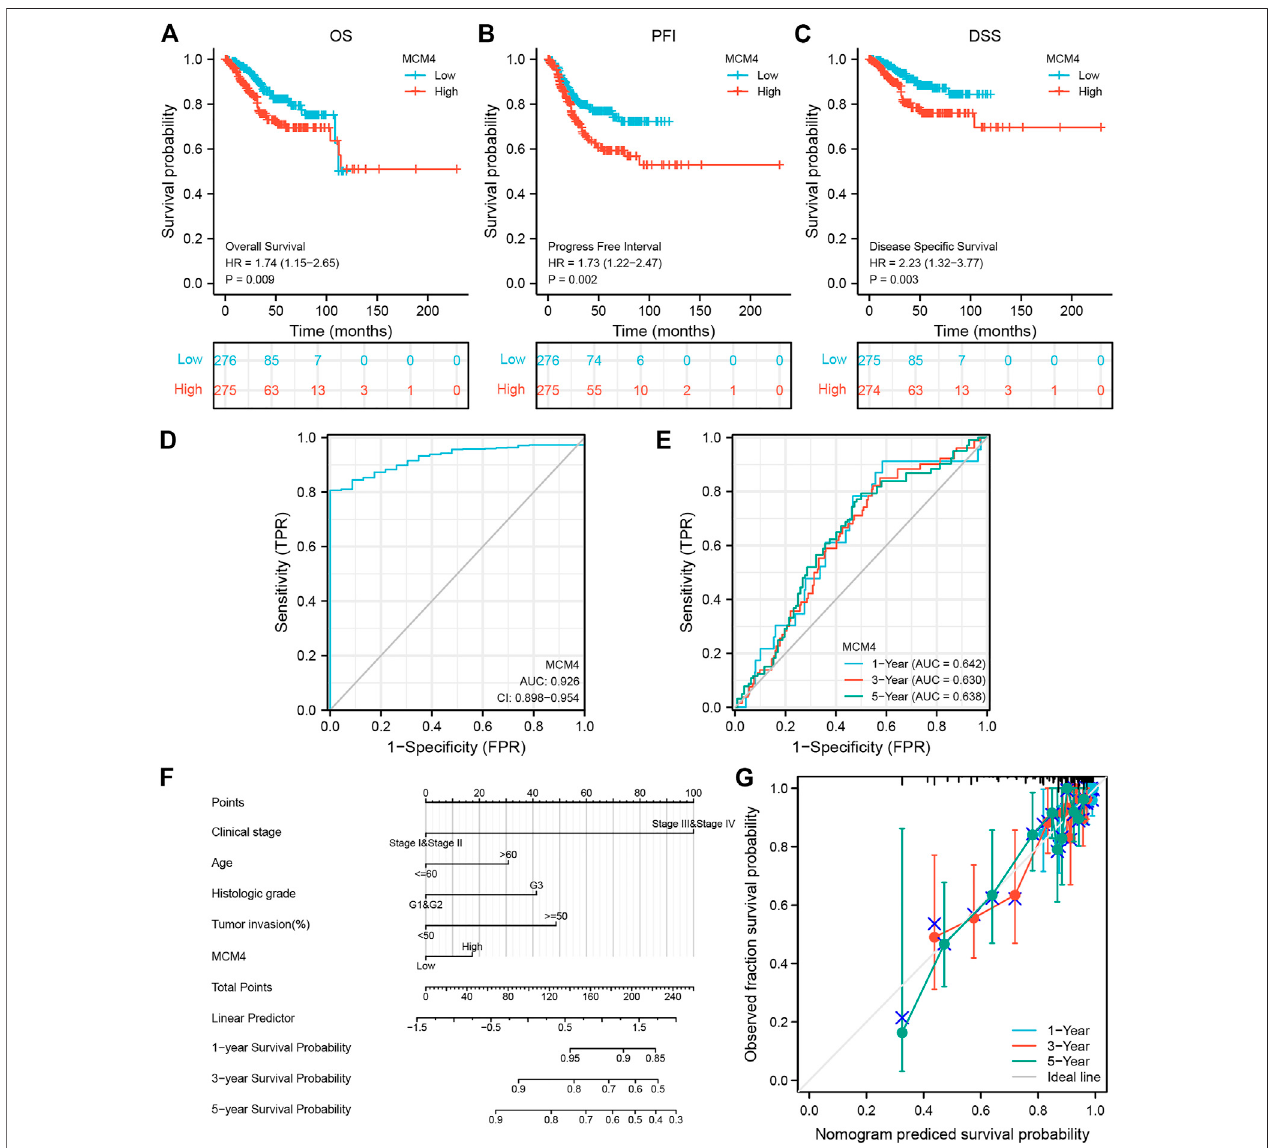
FIGURE 6 | Prognostic model of MCM4 in UCEC. (A) Kaplan-Meier curves showed high expression of MCH4 was associated with poor OS. (B) Kaplan-Meier curvesshowed high expression ofMCH4 wasassociated with poorPFI. (C) Kaplan-Meier curvesshowed high expression ofMCH4 wasassociated with poorDSS. (D) TheAUCvaluesoftheMCM4. (E) TheAUCoftheforthepredictionof1,3,5-yearsurvivalrateofUCEC. (F) NomogramforboththeMCM4andclinicalcharacteristicsto predict 1, 3, 5-year survival rates. (G) Calibration plot for the nomogram predicting the probability of OS at 1, 3, and 5-year. UCEC, uterine corpus endometrial carcinoma. OS, overall survival. PFI, progression-free interval. DSS, disease-speci fi c survival; AUC, area under the curve.